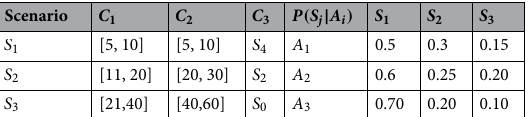
Table 1. The attribute values and priors of the result scenarios under different schemes.